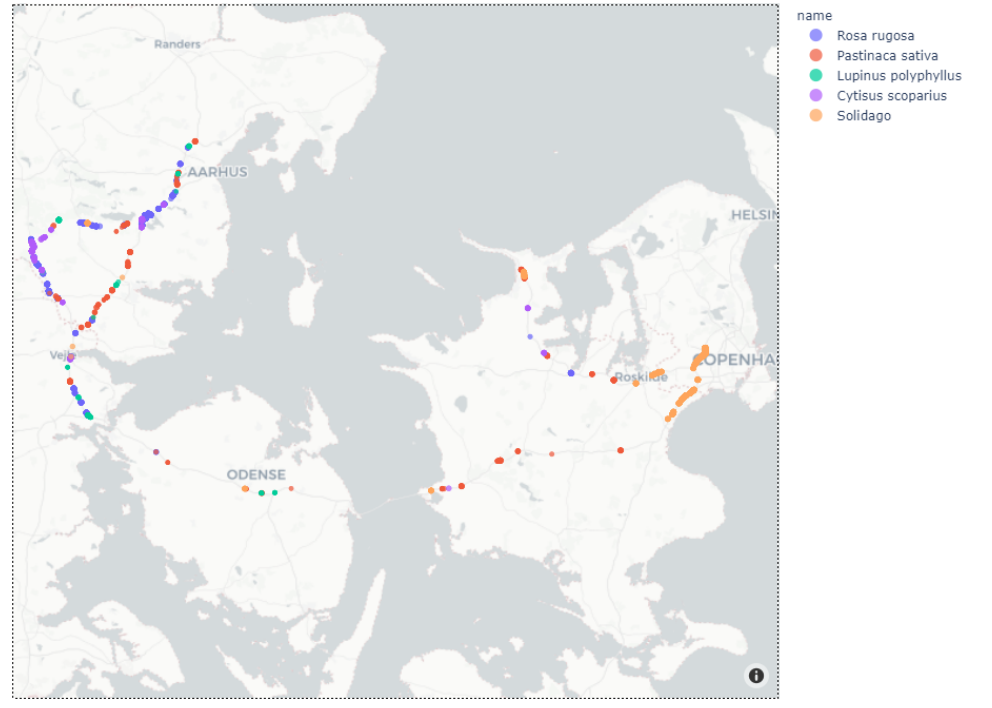
Figure 12. Location of invasive plants found and marked on map of Denmark based on collected and analyzed images in August and September. (© OpenStreetMap